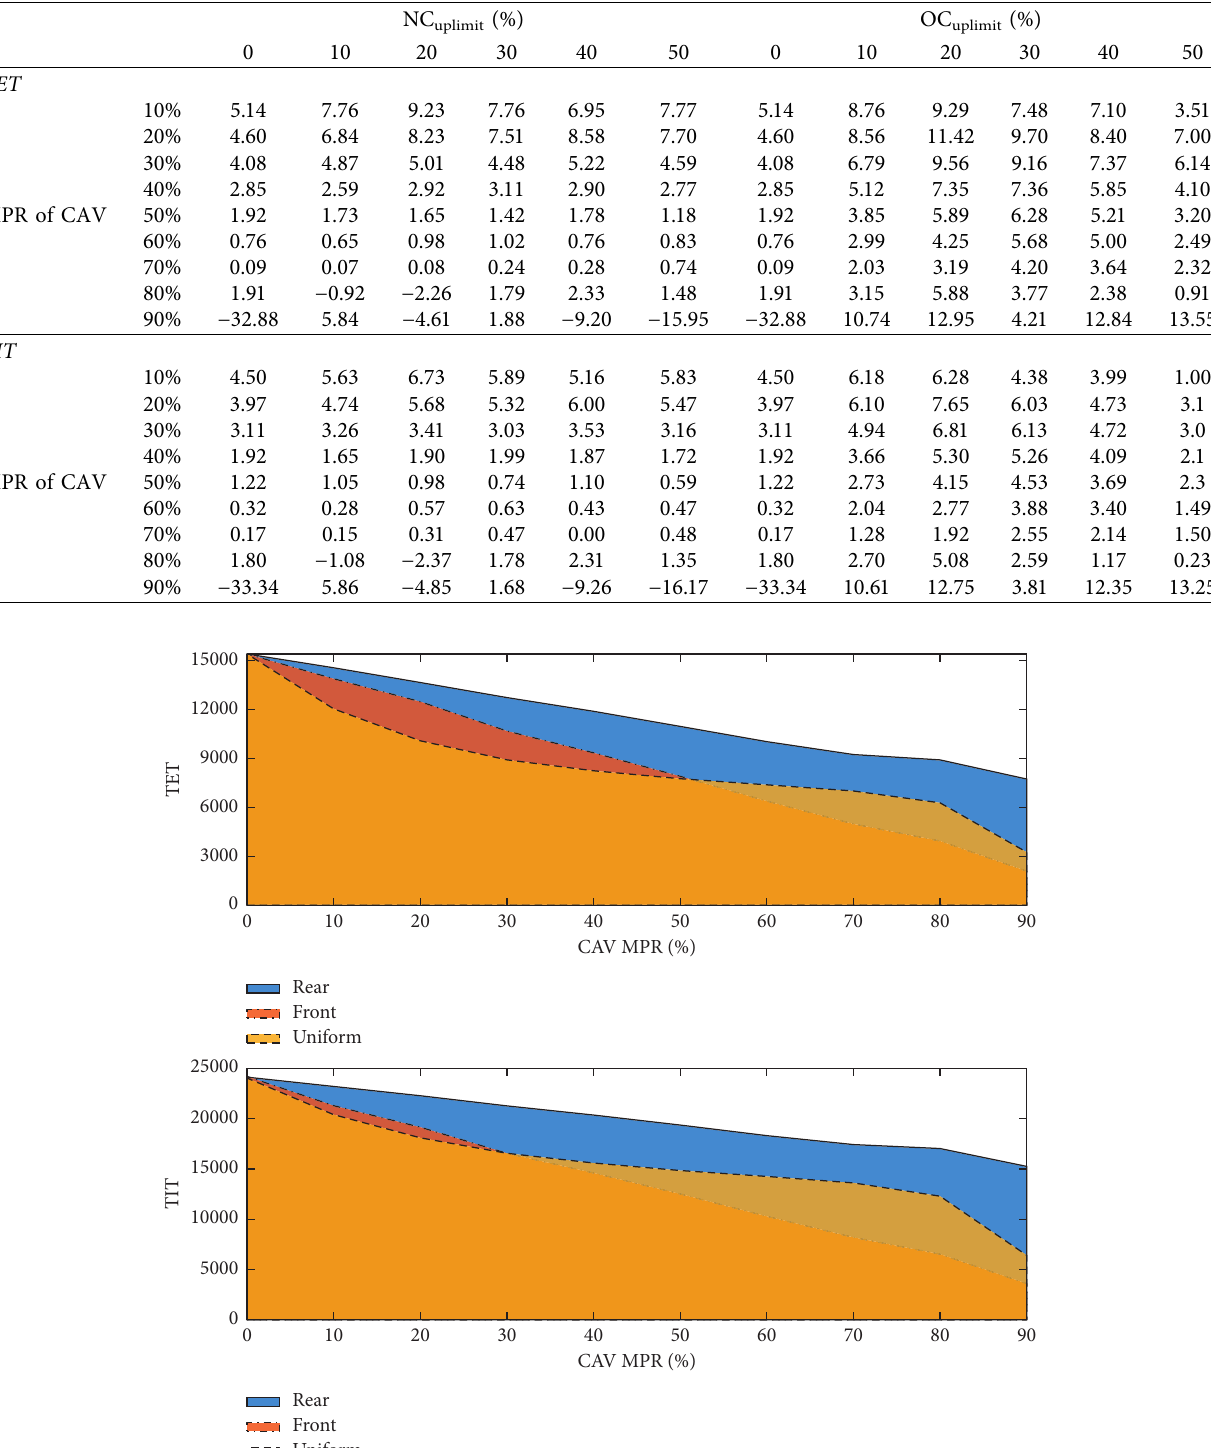
Table 3: Safety improvement rates (long versus medium).